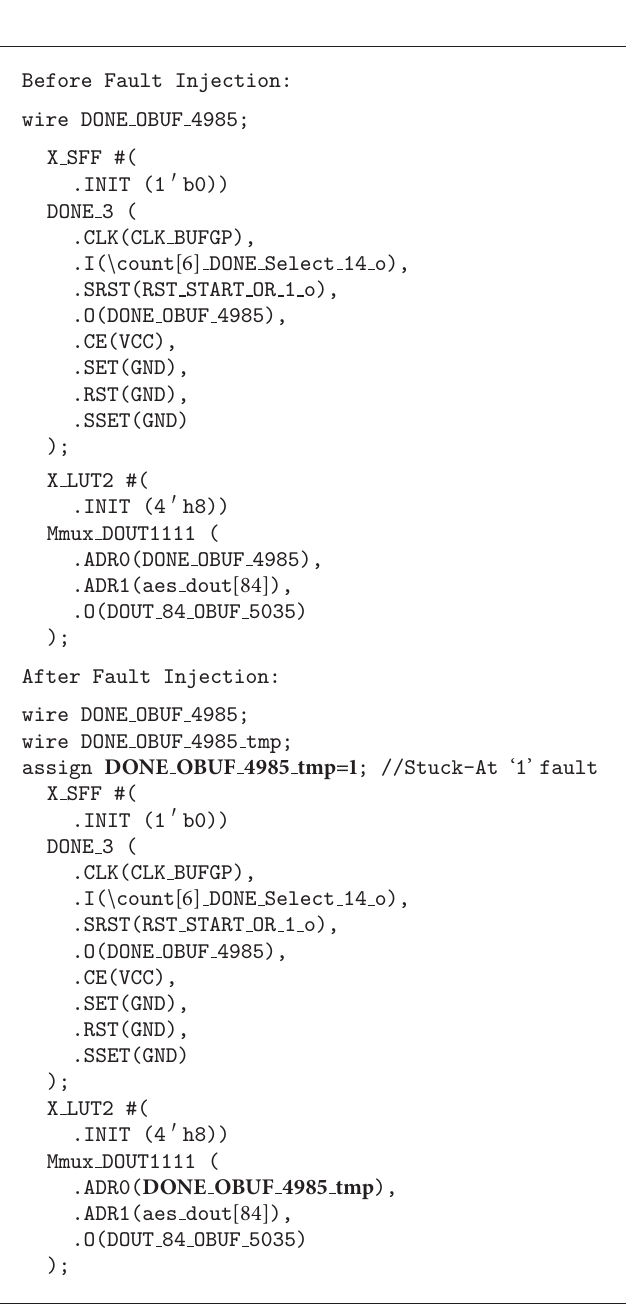
Algorithm 4: An example of fault injection into the simulation model of the